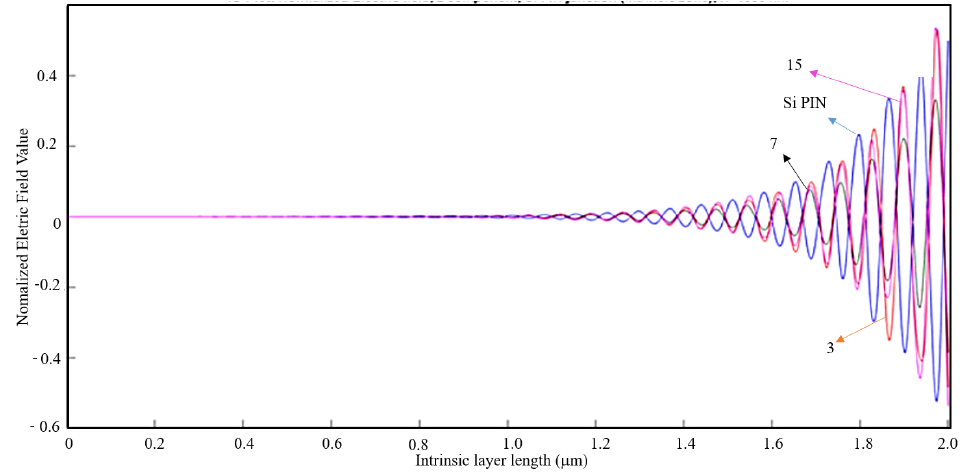
Figure 14. 1D Plot of the normalized electric field, z-component, along the intrinsic zone for a light wavelength of 400 nm: Si PIN junction (blue); 3-slit array Al nanoantenna (red); 7-slit array Al nanoantenna (black); and 15-slit array Al nanoantenna (magenta).